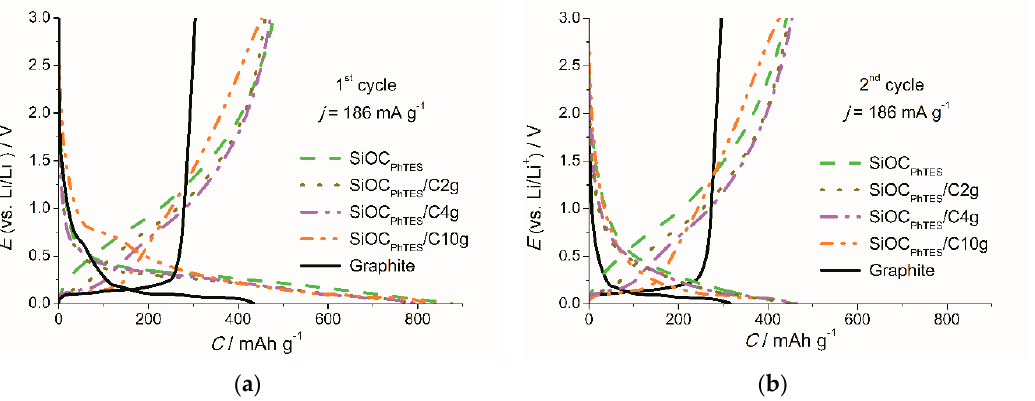
Figure 8. Galvanostatic charge–discharge curves of the investigated materials recorded at the current density (j) of 186 mA g − 1 : ( a ) first, ( b ) second cycle.